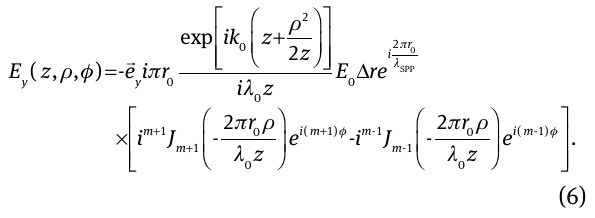
quantum dots in different areas within the spiral antenna are excited. When the excitation spot is away from the geo-